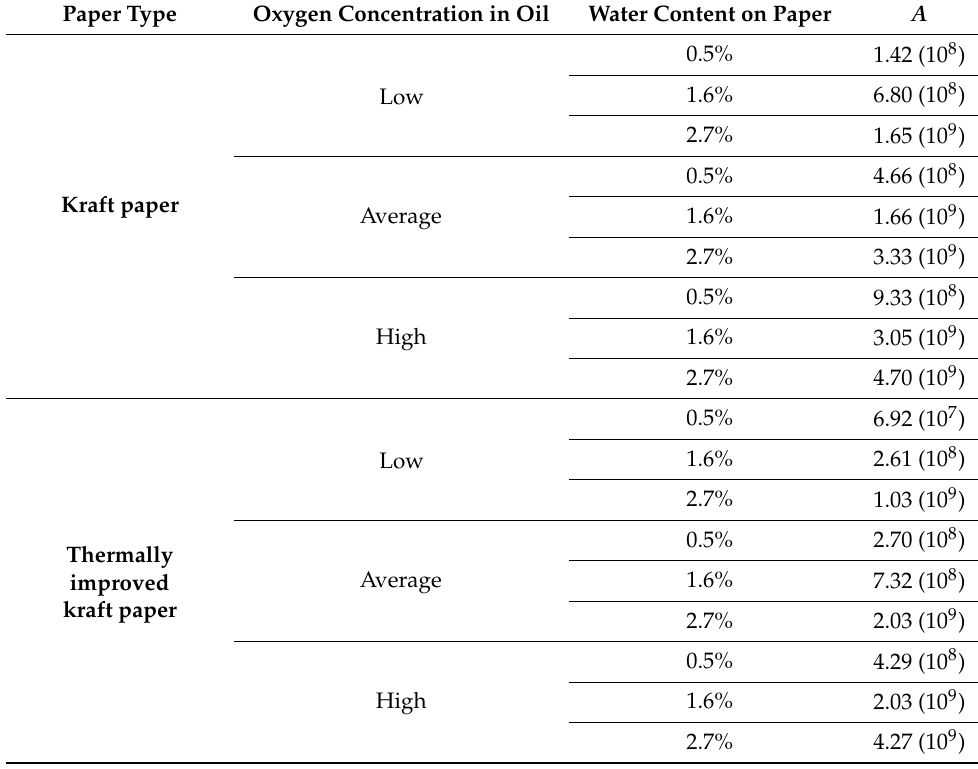
Table 14. Constant A depends on water content, oxygen concentration, and paper type (data in [14]). Paper